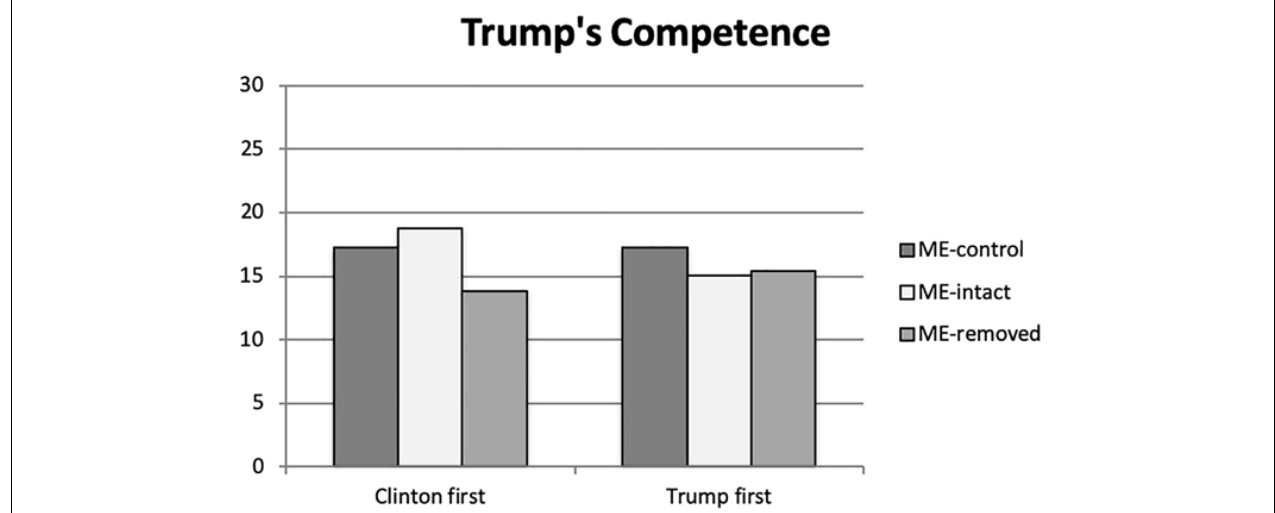
FIGURE 1 | Donald Trump’s perceived competence by Study 1